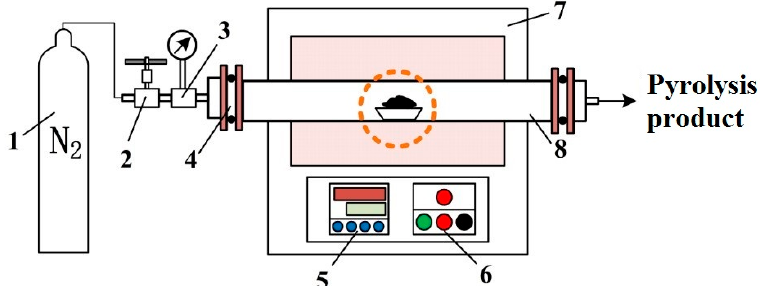
Figure 1. The thermal treatment of molding by tube furnace: (1) nitrogen cylinder, (2) needle valve, (3) gas manometer, (4) sealing flange, (5) control panel, (6) heating switch, (7) thermal-protective coating, (8) quartz tube.